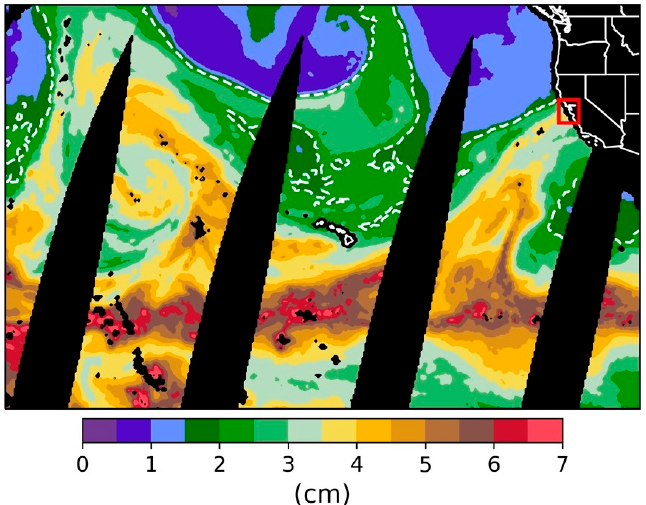
Figure 4. Special Sensor Microwave Imager (SSM/I) satellite image of daily average column integrated water vapor for 16 November, 2017. Red box is the approximate model domain. Dashed white line = 2 cm.